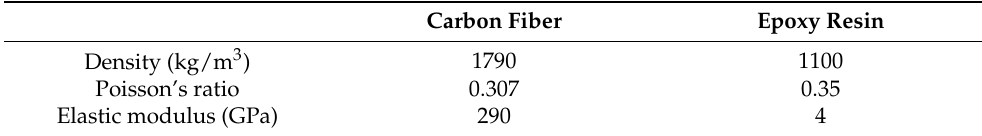
Figure 4. PTW and TTW bending deflection curves under force; cloud diagram of displacement changes after bending under force. ( a ) PTW, and ( b ) TTW. Table 2. Mechanical simulation